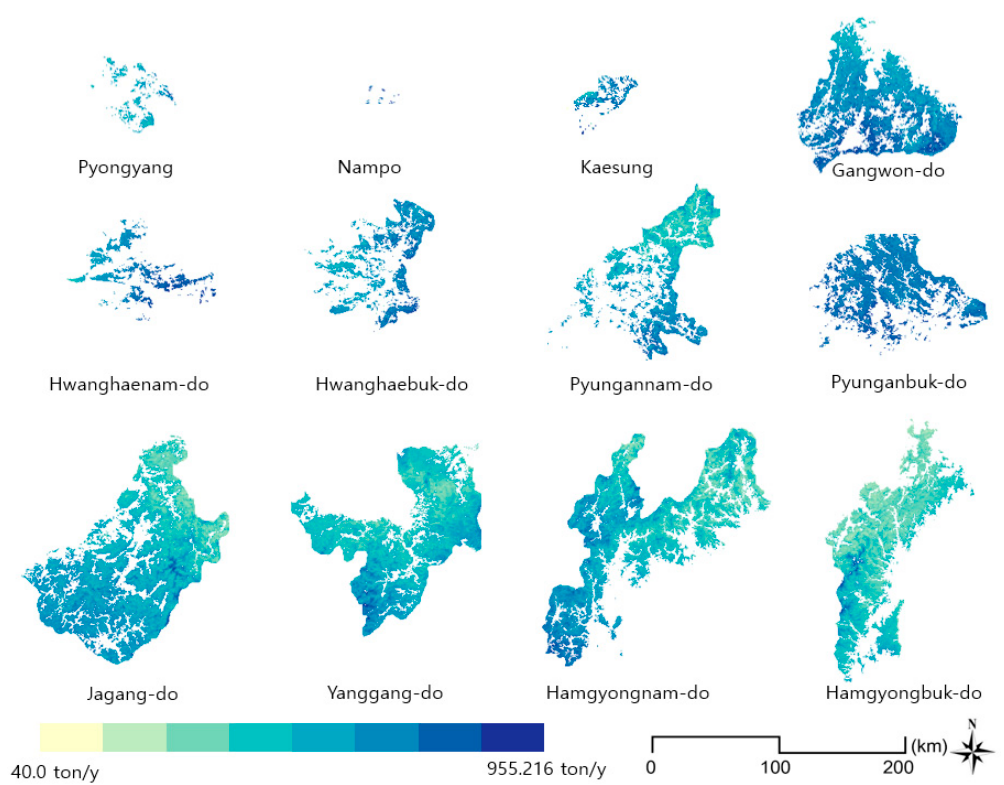
Figure 5. Spatial distribution of the water yield of North Korean forests by administrative district.